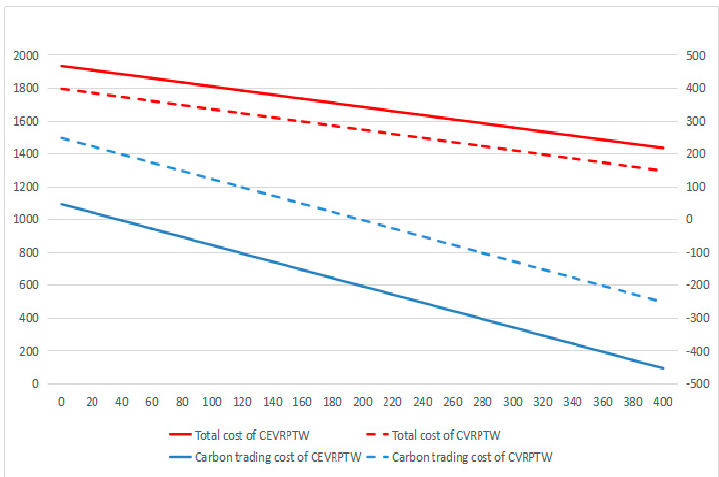
is 0.05. Int. J. Environ. Res. Public Health 2019 , 16 , x is 0.05.